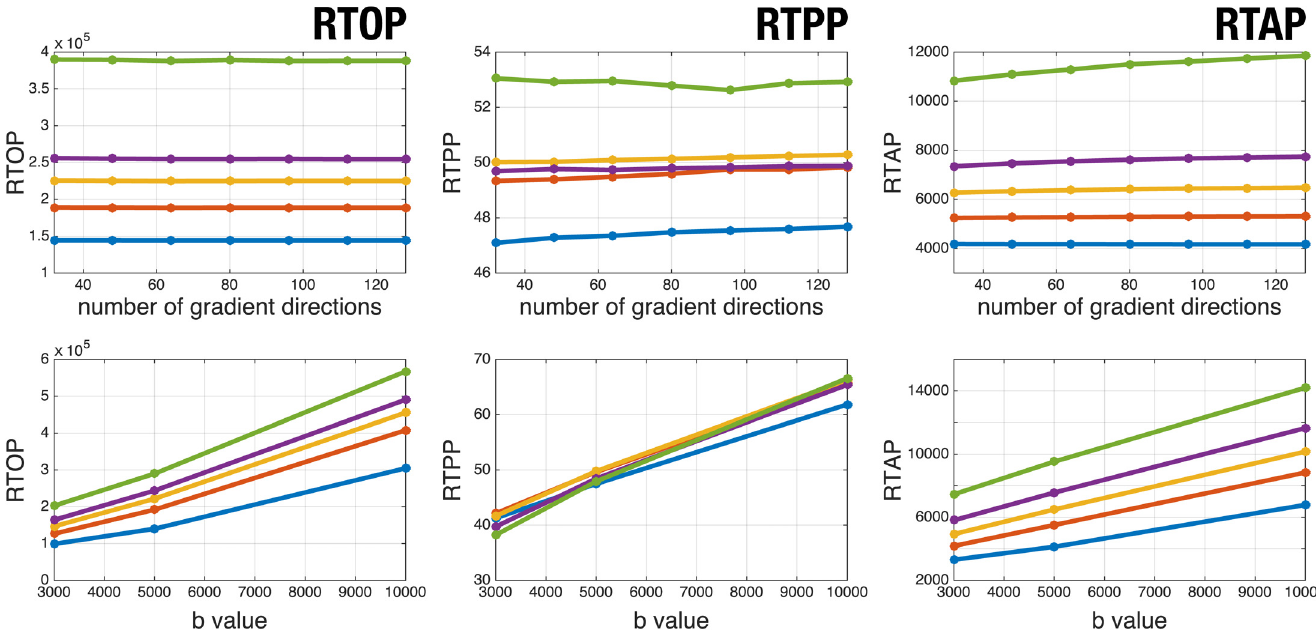
Fig 6. Apparent values of AMURA as a function of the number of acquired gradients (top) or the b-value (bottom) for subject MGH 1016. Each line correspond to a cluster of FA values computed from 5-fold fuzzy c-means. AMURA as a function of the number of gradients (top) are depicted at b = 5,000s/mm 2 .